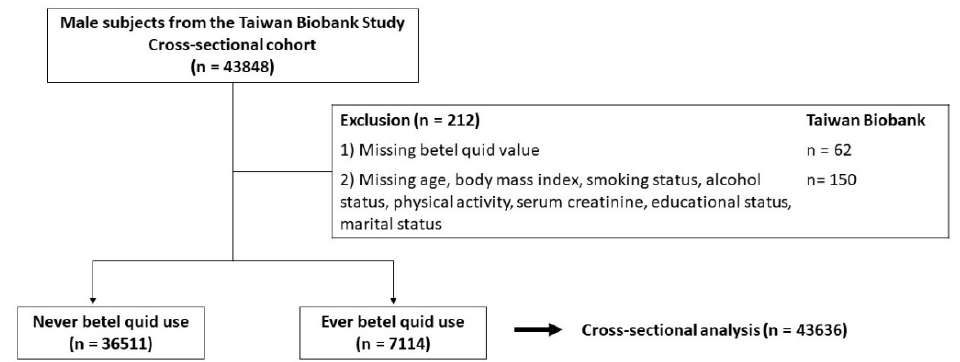
Figure 1. Study participants were classified by status of betel